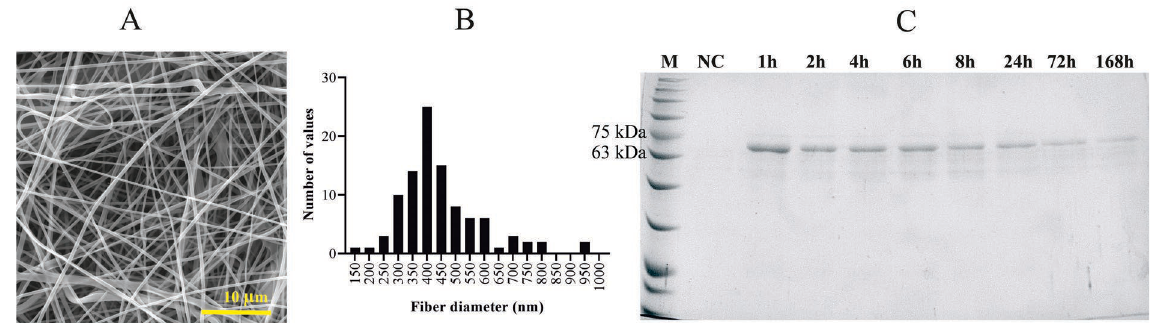
Figure 4. ( A ) SEM image of electrospun PVA with incorporated platelet lysate (PVA_PL), scale bar 10 µm; ( B ) histogram of the fiber diameter distribution in PVA_PL material; ( C ) 10% SDS-PAGE documenting the protein release from PVA_PL after 1, 2, 4, 6, 8, 24, 72 and 168 h in PBS; PVA material without incorporated proteins served as negative control (NC), Coomassie blue staining.